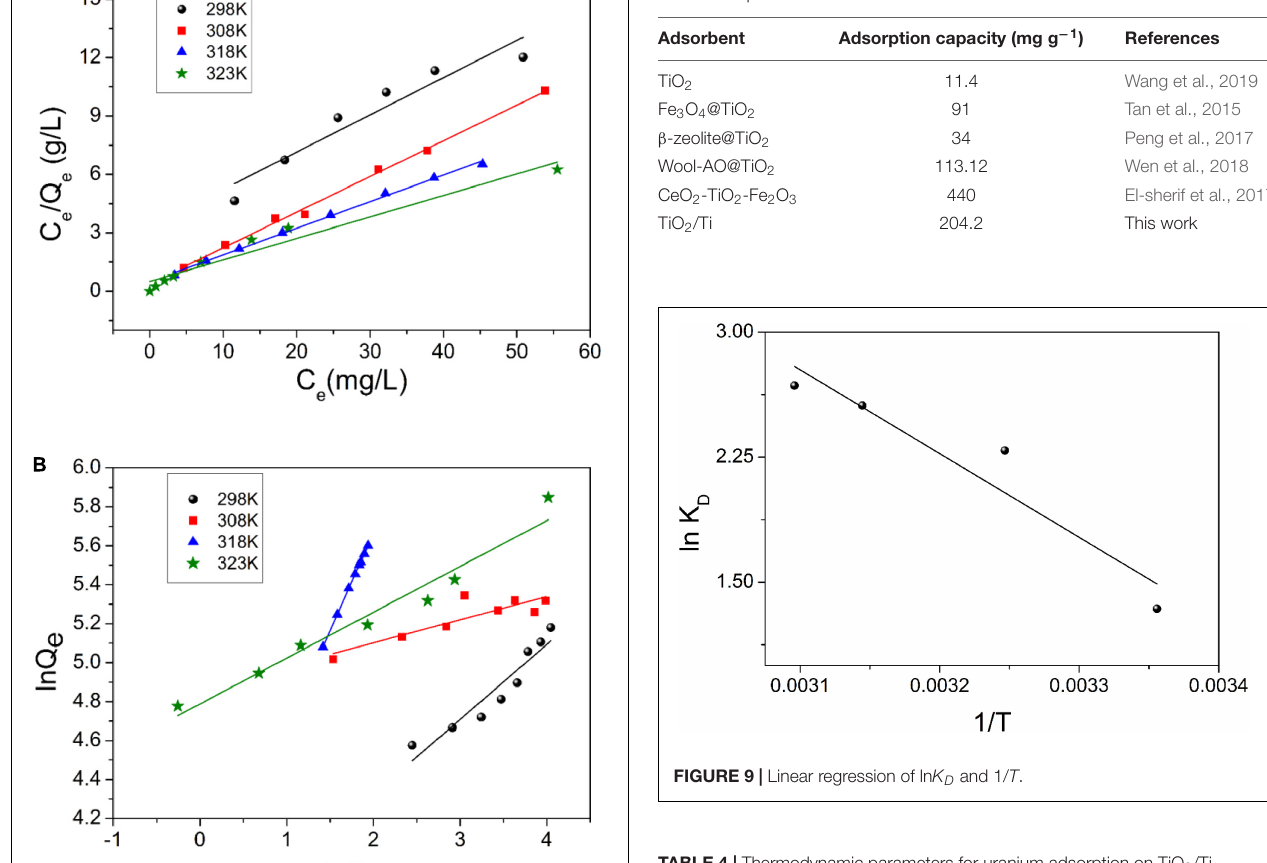
TABLE 3 | The comparison of uranium (I) adsorption capacity onto different TiO 2 and its composites at 298 K.